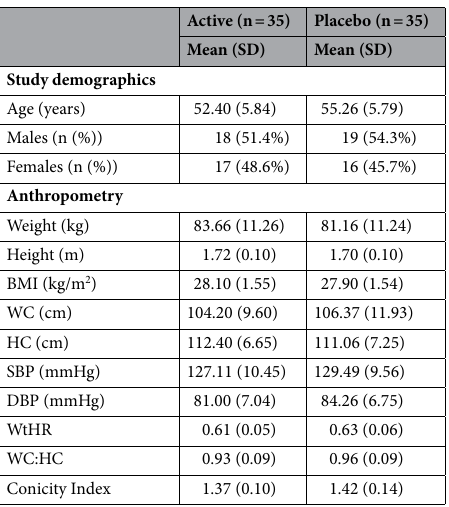
Table 1. Demographic and baseline characteristics of the PROBE population. The data represents the mean ± standard deviation (SD) of 35 participants in each group. The number of participants (n) that were male or female in each group are expressed as a percentage of the total group size. BMI body mass index, WC waist circumference, HC hip circumference, SBP systolic blood pressure, DBP diastolic blood pressure, WtHR waist-to-height ratio, WC:HC waist-to-hip ratio.